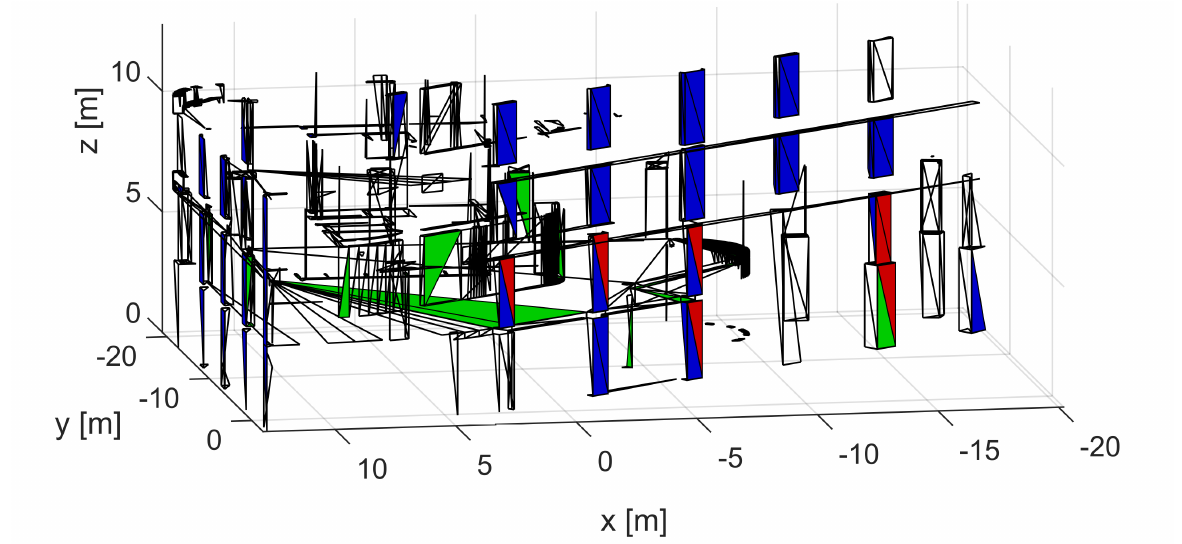
Figure 10. Final result showing the confirmed triangles for both time steps. Triangles labeled as potentially built but have not been confirmed are uncolored. The green triangles are confirmed by the point cloud of time step 1, blue triangles are confirmed by the point cloud of time step 2 and red triangles are confirmed in both of the time